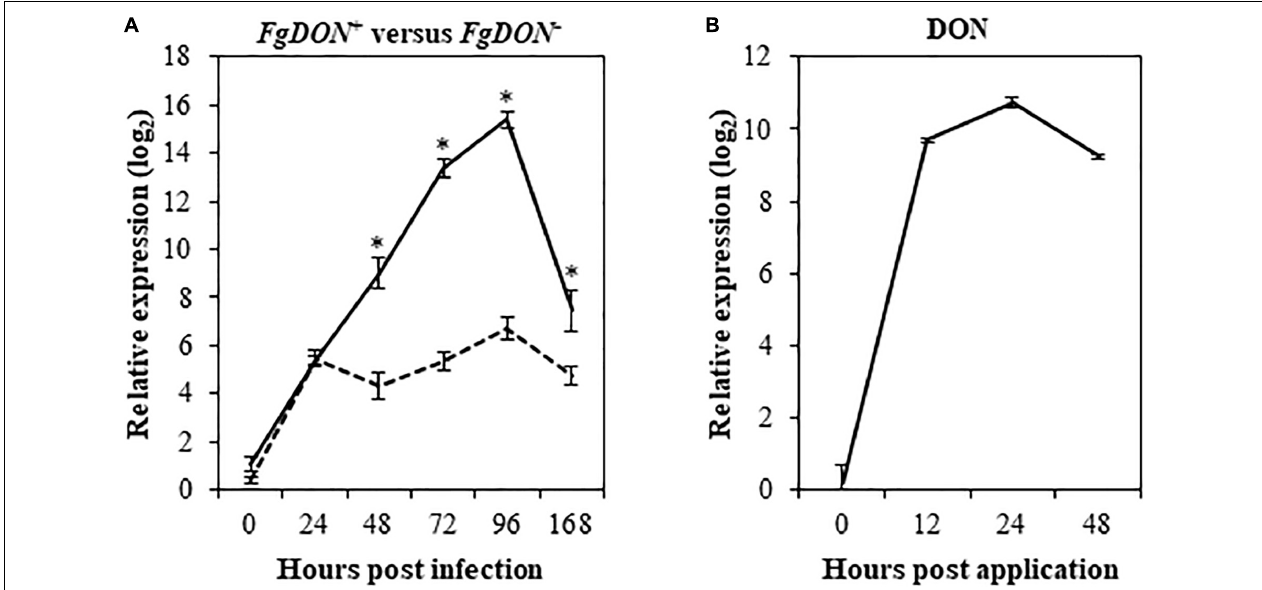
FIGURE 1 | The Bradi1g75310 ( BdCYP711A29 ) gene is transcriptionally induced during FHB and following DON treatment. Relative quantification of Bradi1g75310 transcripts in the Bd21-3 (WT) ecotype of B. distachyon following F. graminearum infections or following DON treatment. (A) Bradi1g75310 expression level (fold-change. log 2 ) following point infection with the FgDON + (solid line) or with the FgDON - (dashed line) strain of F. graminearum compared to mock treatment. (B) Bradi1g75310 expression level (fold-change. log 2 ) following DON treatment compared to mock treatment. The relative quantity of the Bradi1g75310 transcripts compared to mock condition was calculated using the comparative cycle threshold (Ct) method (2 − (cid:49)(cid:49) Ct ). The B. distachyon UBC18 and ACT7 genes ( Bradi4g00660 and Bradi4g41850 ) were used as endogenous controls to normalize the data for differences in input RNA between the different samples. Mean of three independent biological replicates ± standard deviation. Asterisks indicate significant differences between conditions (Student’s t- test p value <